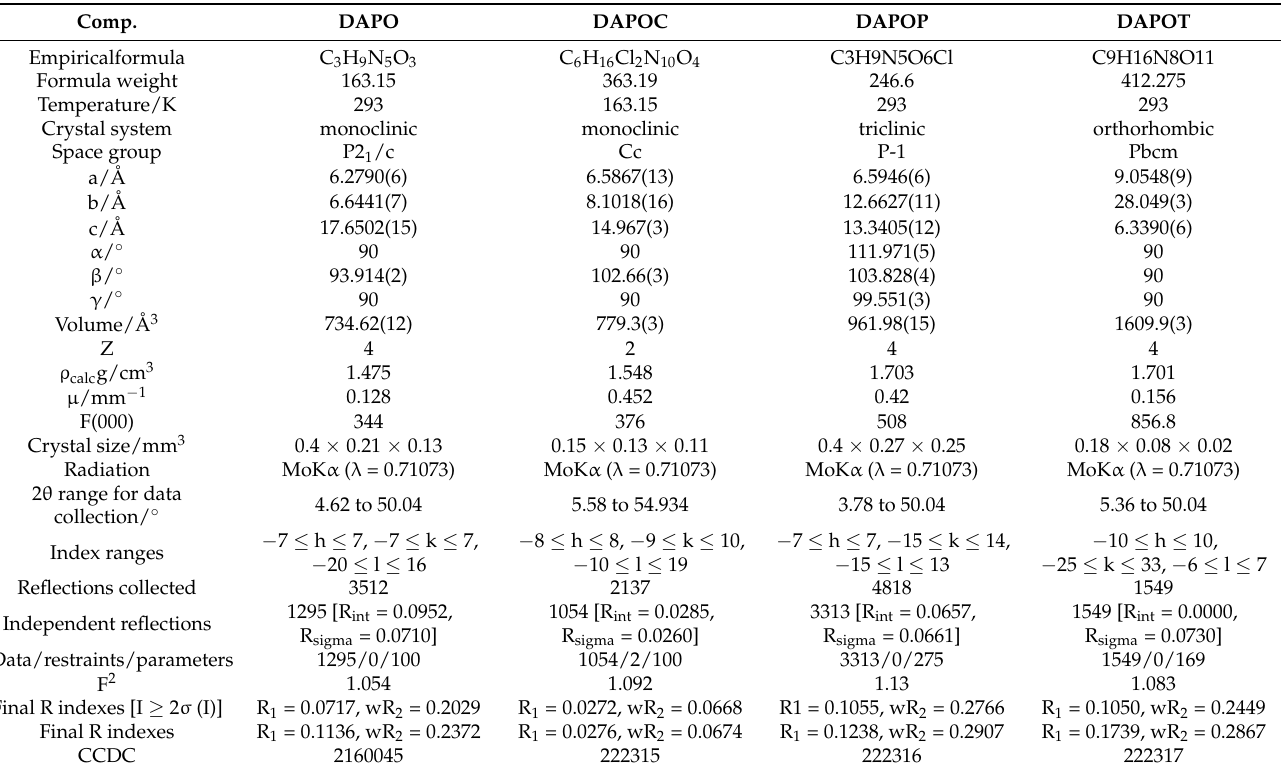
Table 1. Crystal data and structure refinement for DAPO and its salts.